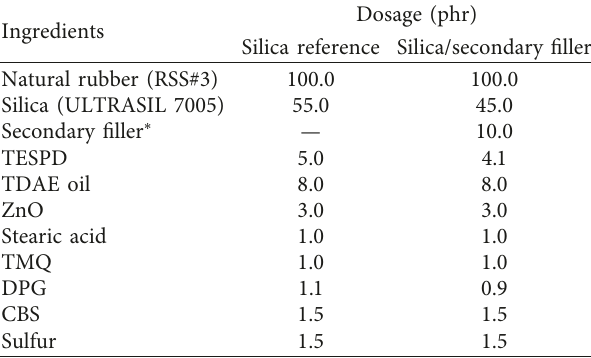
Table 1: Compound formulations used for this study.